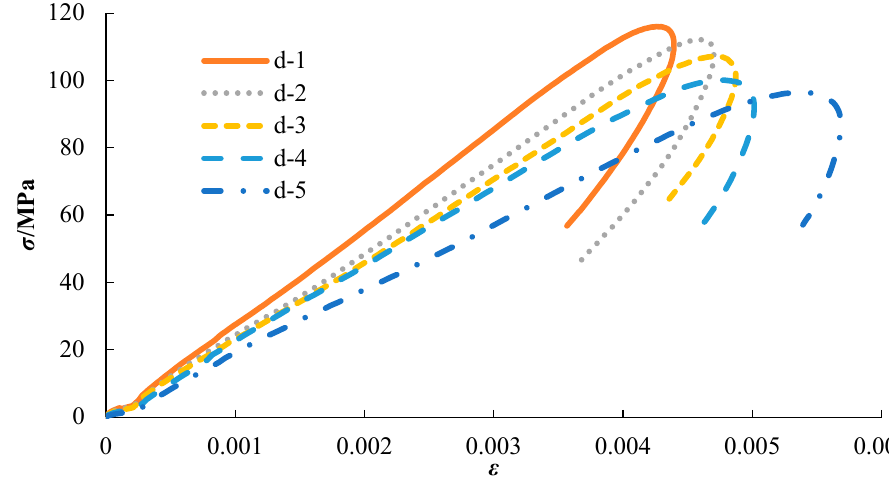
Figure 2. Stress-strain curves of dry samples. Figure 2. Stress ‐ strain curves of dry samples. Figure 2. Stress ‐ strain curves of dry samples.